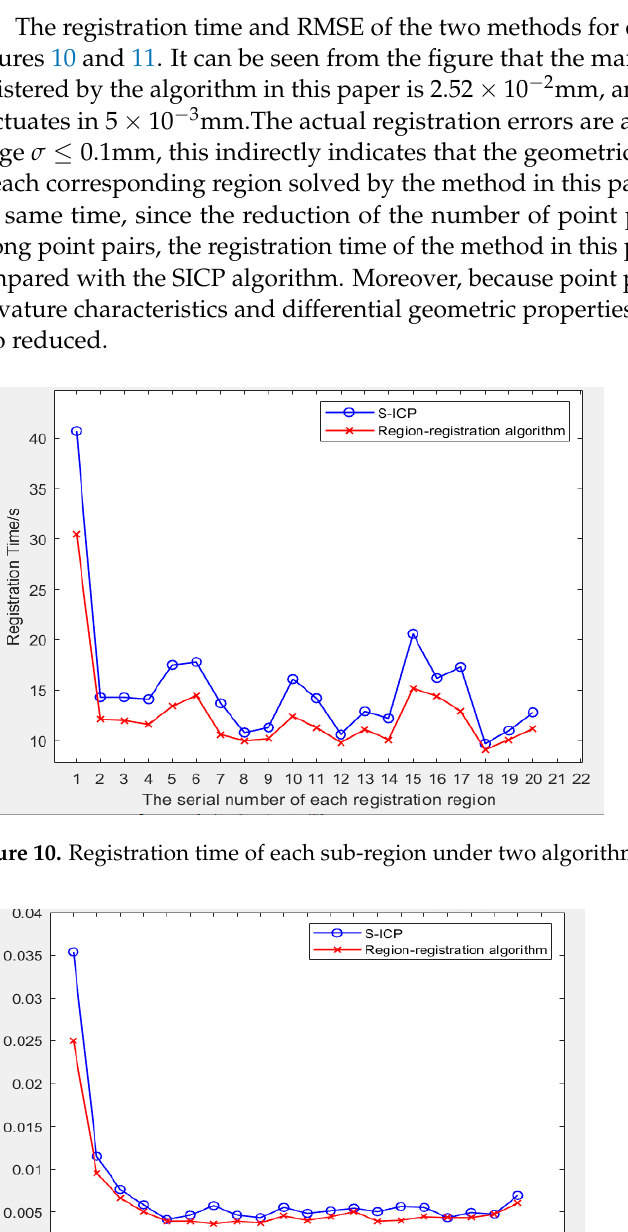
Figure 9. Point cloud registration for each sub-region.